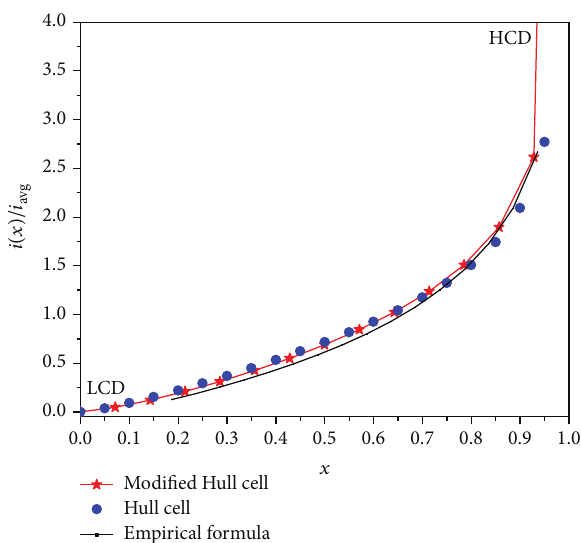
Figure 6: The distribution of electrolyte current density stream lines in modified Hull